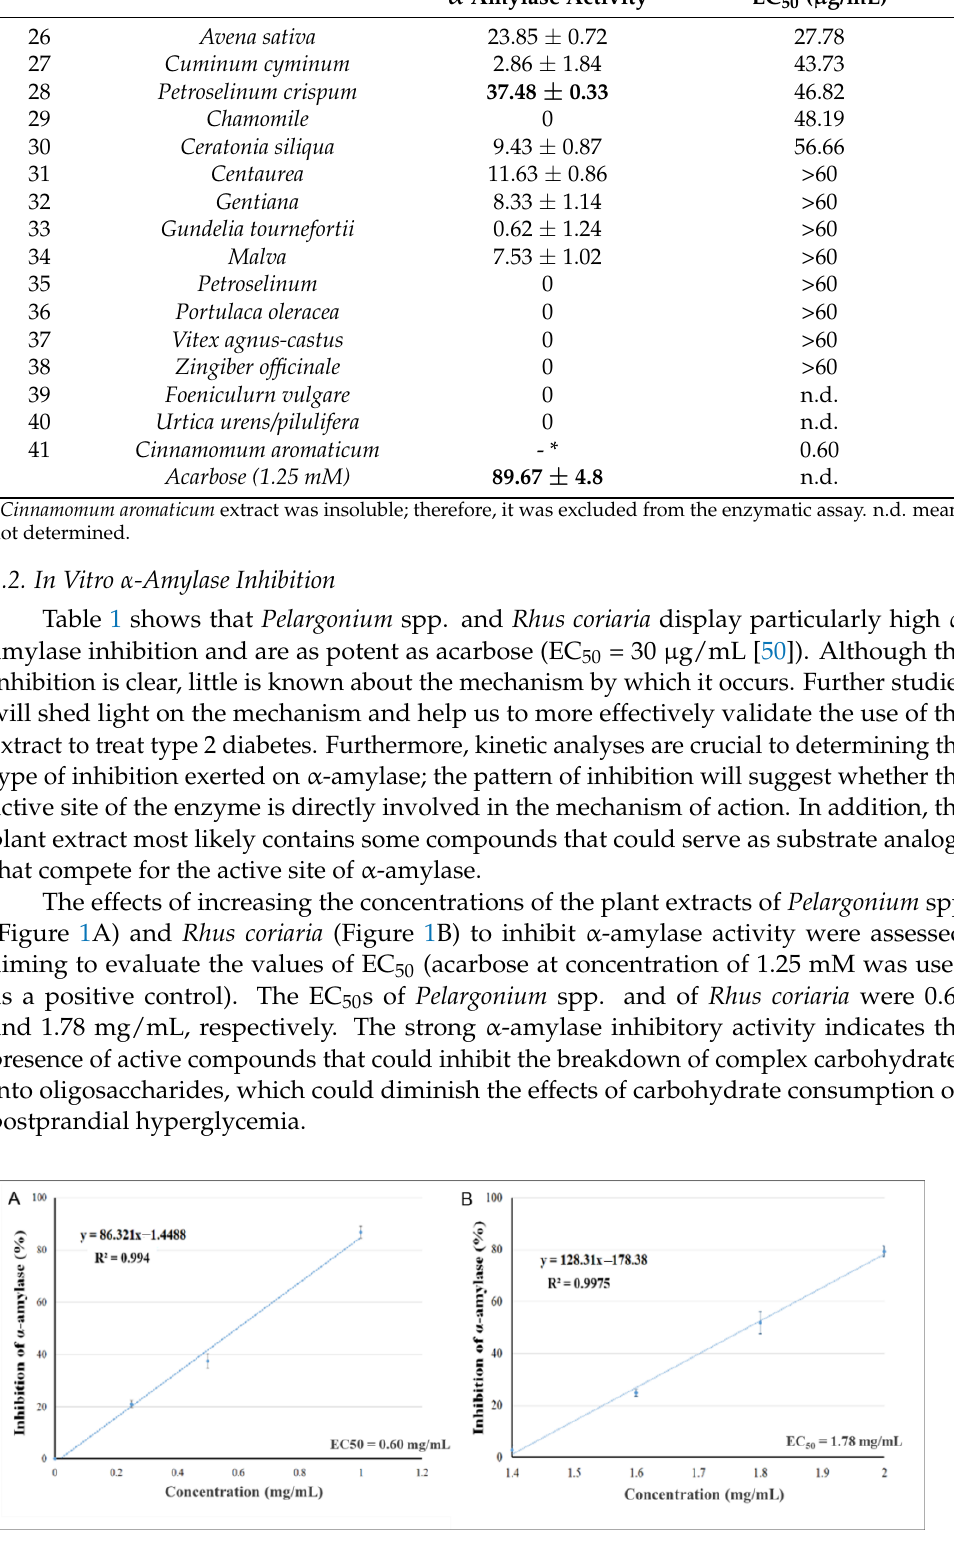
Figure 1. Inhibitory activity of Pelargonium spp. ( A ) and Rhus coriaria ( B ) against α-amylase.